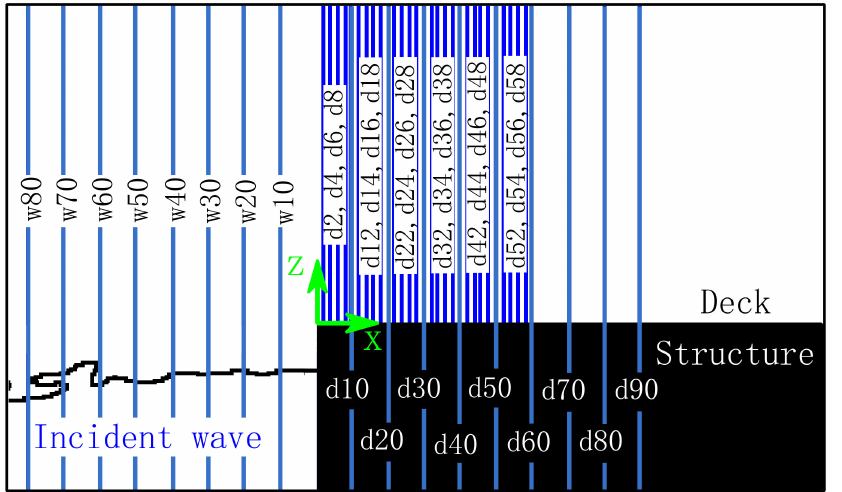
Figure 4. Distribution of VWPs along the horizontal domain of the images. The letters “ d ” and “ w ” mean “over the deck (+ x )” and “wave, outside the deck ( − x )”, respectively. The number next to these letters indicates the distance, in mm, from the origin ( x =